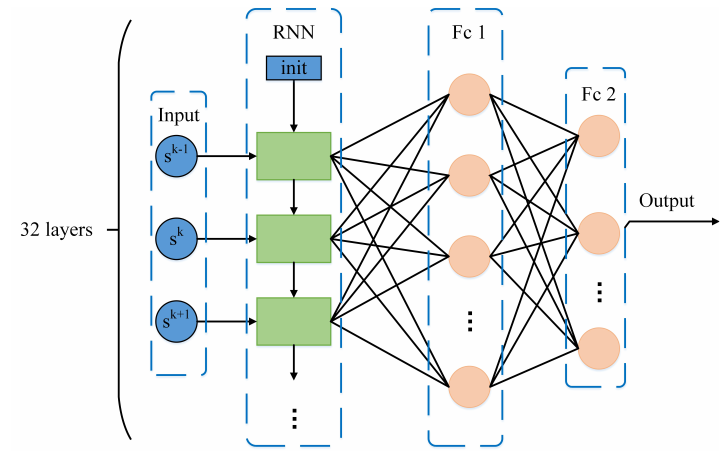
Figure 4. Structure of RFc neural network for approximating Q-function.